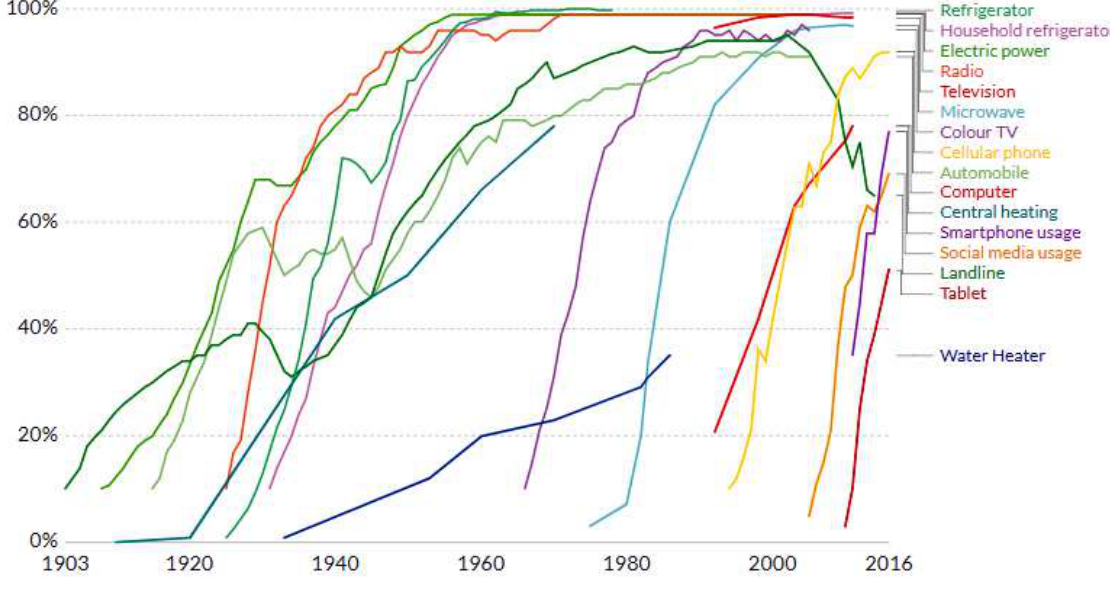
Figure 14. Technology adoption in US